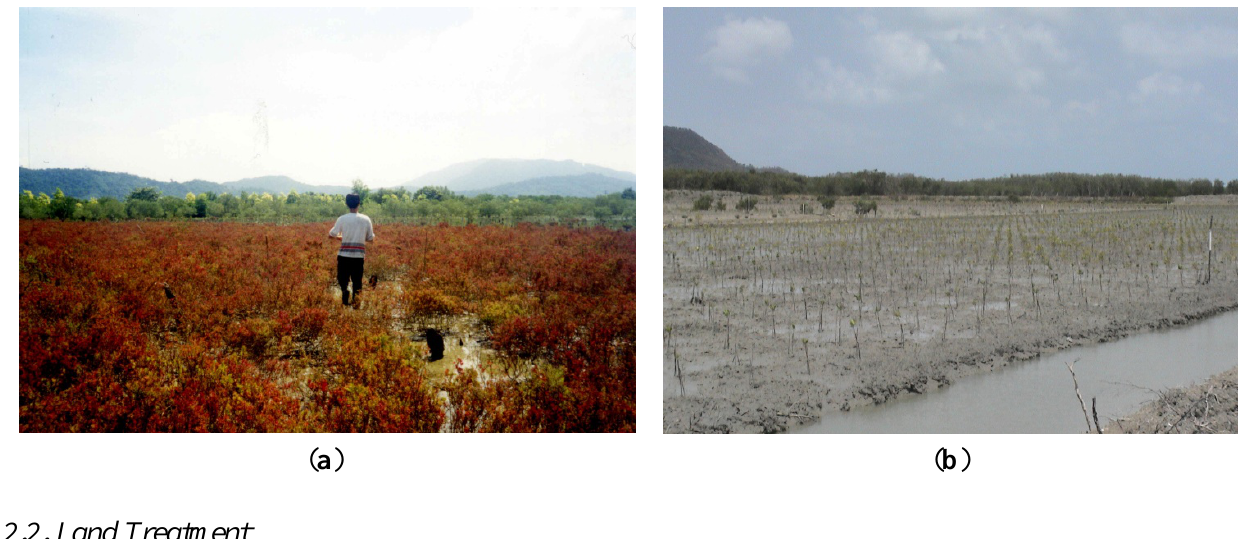
Figure 3. ( a ) Condition of the study site before the land treatment (August 2001). Note that the study site was fully covered by Suaeda maritime , which is a common halophyte in the region; ( b ) The study site immediately after mangrove planting (September 2001). In the foreground is the excavated area and in the background the unexcavated area, the difference of the ground level between the two areas is 25